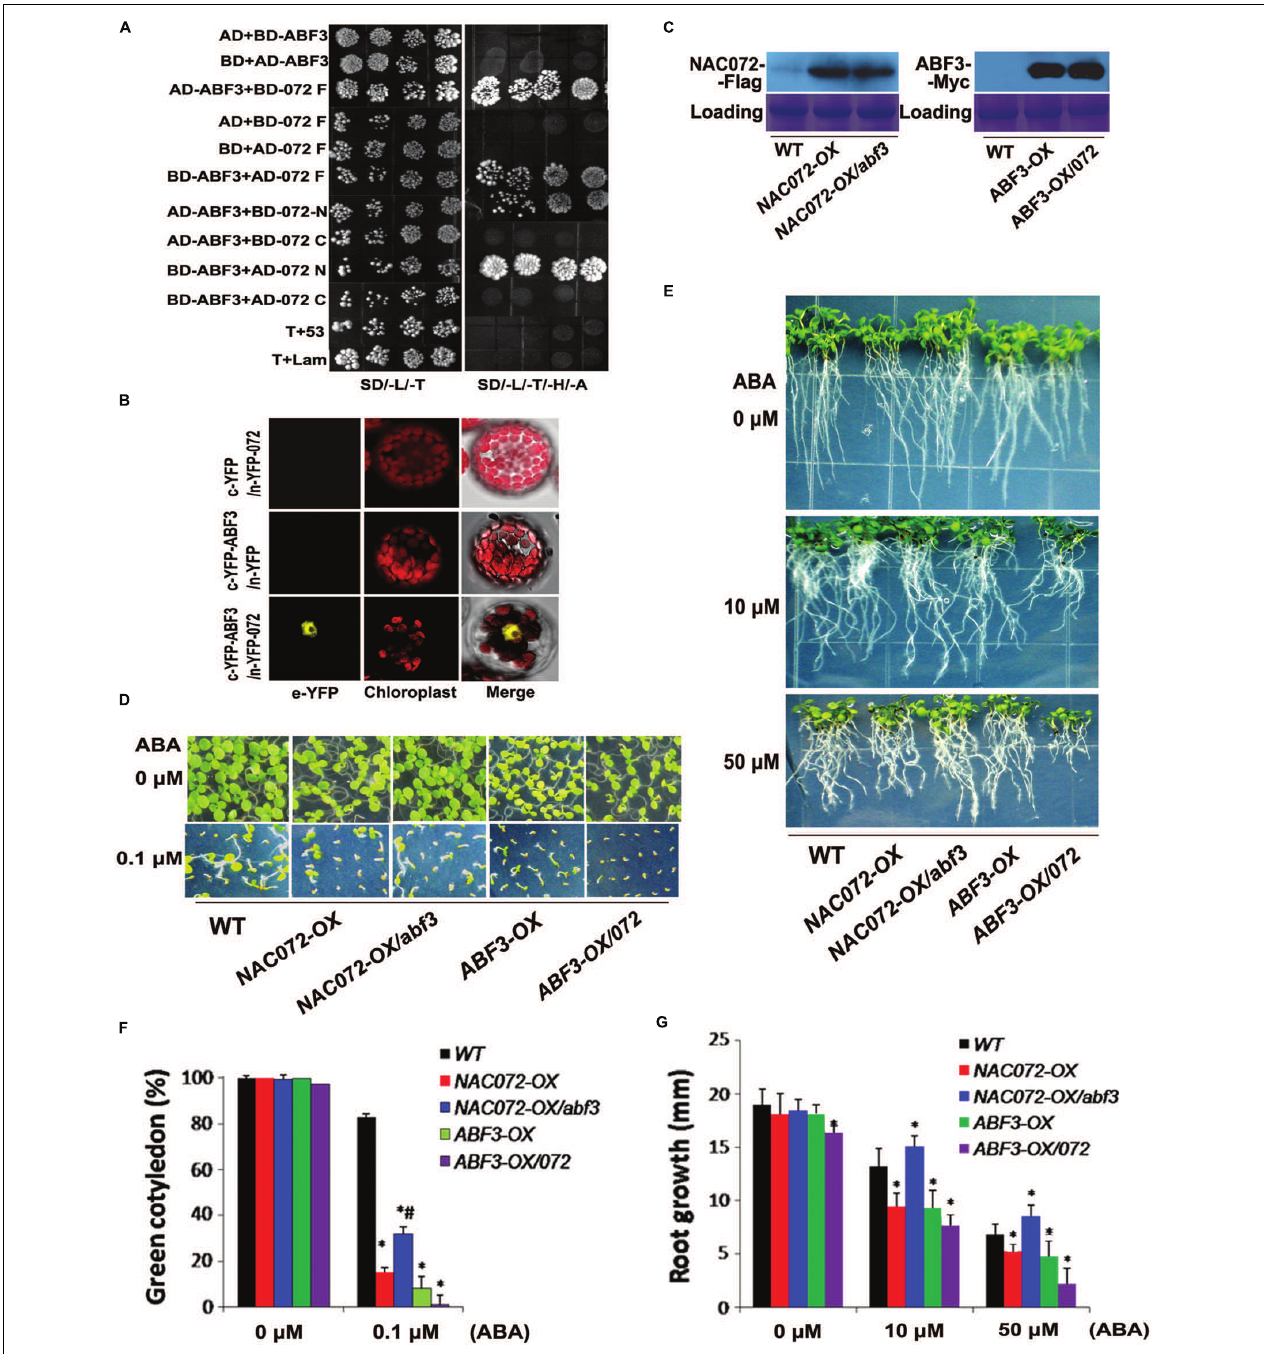
FIGURE 2 | The dual function of NAC072 in ABF3-mediated ABA response. (A) Interactions between ABF3 and both full length and sections (C- and N-terminal regions) of NAC072 were confirmed by yeast two-hybrid assay. The 072 F indicates NAC072 full length, 072 N or C indicates NAC072 N-terminal regions or C-terminal regions, respectively. T + 53 and T + Lam were used as the negative controls. (B) Interactions of ABF3 and NAC072 were observed by BiFC assay. (C) NAC072 or ABF3 protein accumulation in the transgenic plants detected by western blot. (D) Photographs of seedlings recorded at 7 days after stratification on agar plates containing 0, or 1 µ M ABA. (E) Photographs of seedlings recorded at 20 days after transferral to control agar plates (0 µ M ABA) or plates containing 10 or 50 µ M ABA. NAC072-OX or ABF3-OX indicates NAC072 or ABF3 overexpressed in WT under the control of the cauliflower mosaic virus (CaMV) 35S promoter, respectively. NAC072-OX / abf3 or ABF3-OX / 072 indicates NAC072 or ABF3 overexpressed in abf3 or nac072, respectively. (F) The statistical analysis of green cotyledons in (D) . Bars indicate standard deviation, n = 30. (G) The statistical analysis of axial root growth in (E) . Bars indicate standard deviation, n = 10. ‘ ∗ ’ indicates a significant difference between ABF3 or NAC072 transgenic plants compared with WT plants under the same ABA treatment ( P < 0.05). ‘ # ’ indicates a significant difference between NAC072-OX / abf3 compared with NAC072-OX plants or ABF3-OX / 072 compared with ABF3-OX plants ( P < 0.05).